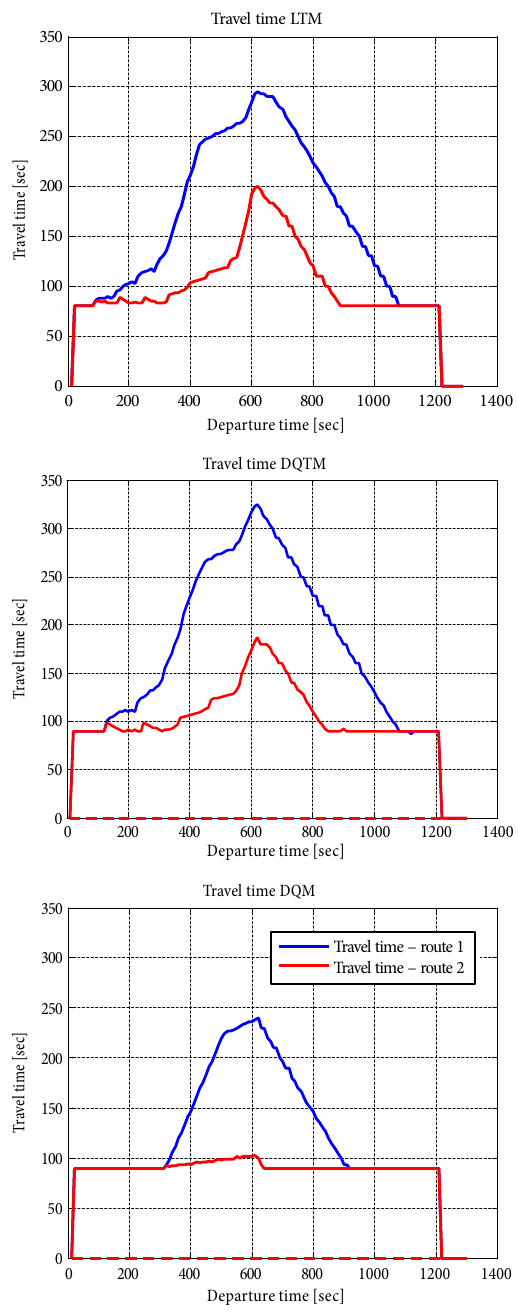
Fig. 3. Travel time for the single-class